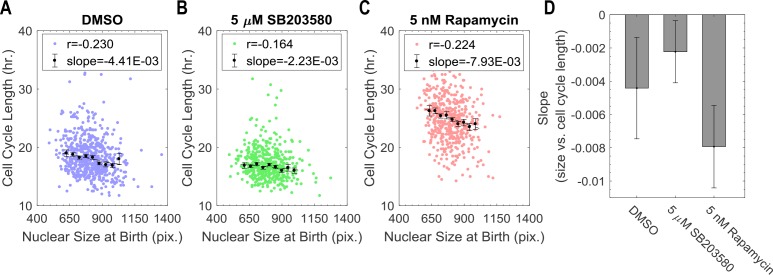
Cell size at birth is negatively correlates with cell cycle duration. p38 inhibition, but not mTORC1 inhibition weakens this correlation.(A–C) Scatterplots displaying relationship between nuclear size at birth with cell cycle duration for individual cells in DMSO control, p38 inhibition and mTOR inhibition. The points with error bar shows mean and SEM by binning cells with similar size. The dashed line shows the result of linear regression with the binned data. Measurements were obtained from time-lapse experiments as indicated in Figure 3. (D) Bar plot comparing the slopes of the linear regression between size and G1 duration as shown in panel A–C. Error bar indicates 95% confidence bounds. The meta data and source code used to in this analysis is presented in Figure 3—source data 2.